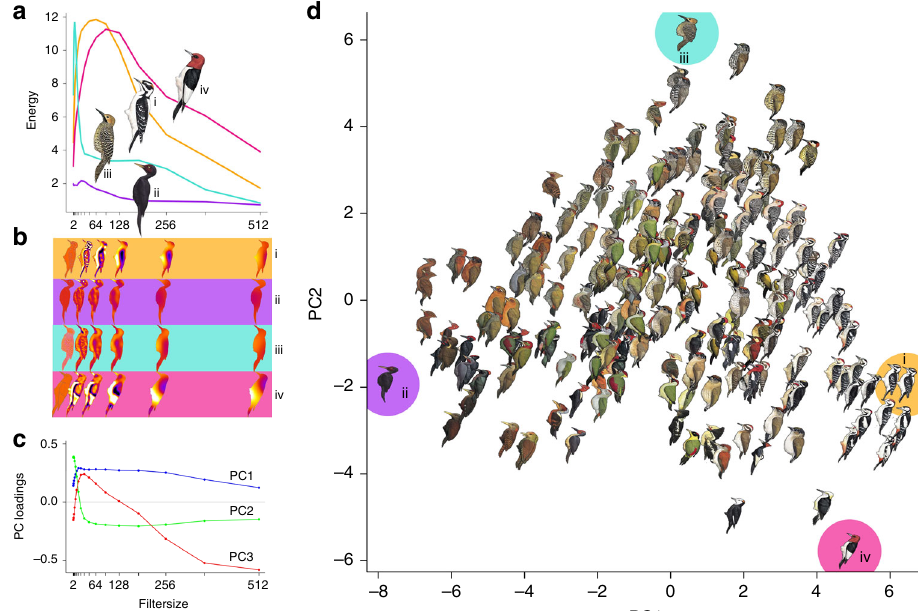
Fig. 3 Major axes of plumage pattern variation, summarized with principal components analysis (PCA). From granularity analysis, these values are used for species-level approaches. a Pattern energy spectra for exemplar species characterized by maximally divergent PC scores (i = Dryobates villosus , ii = Mulleripicus funebris , iii = Colaptes fernandinae , iv = Melanerpes erythrocephalus ). These show information on relative contributions of different granularities to overall appearance. b Pattern maps of exemplar species enable visualization of energy at subsets of isotropic band-pass fi lter sizes (2, 32, 64, 128, 256, and 512 pixels). c Principal component loadings of pattern energy spectra across fi lter size for all species reveals how pattern elements of different sizes in fl uence PC scores. d Pattern PC1 and PC2, collectively, account for 82.1% of variation across woodpeckers. Species (i – iv) illustrate the extremes of variation along PC1 and PC2: (i) exhibits high energy scores across most pattern element sizes, with small, medium, and large pattern elements; (ii) has low energy scores across the spectrum, with few pattern elements of any size; (iii) has many small pattern elements and few of any other sizes; (iv) has